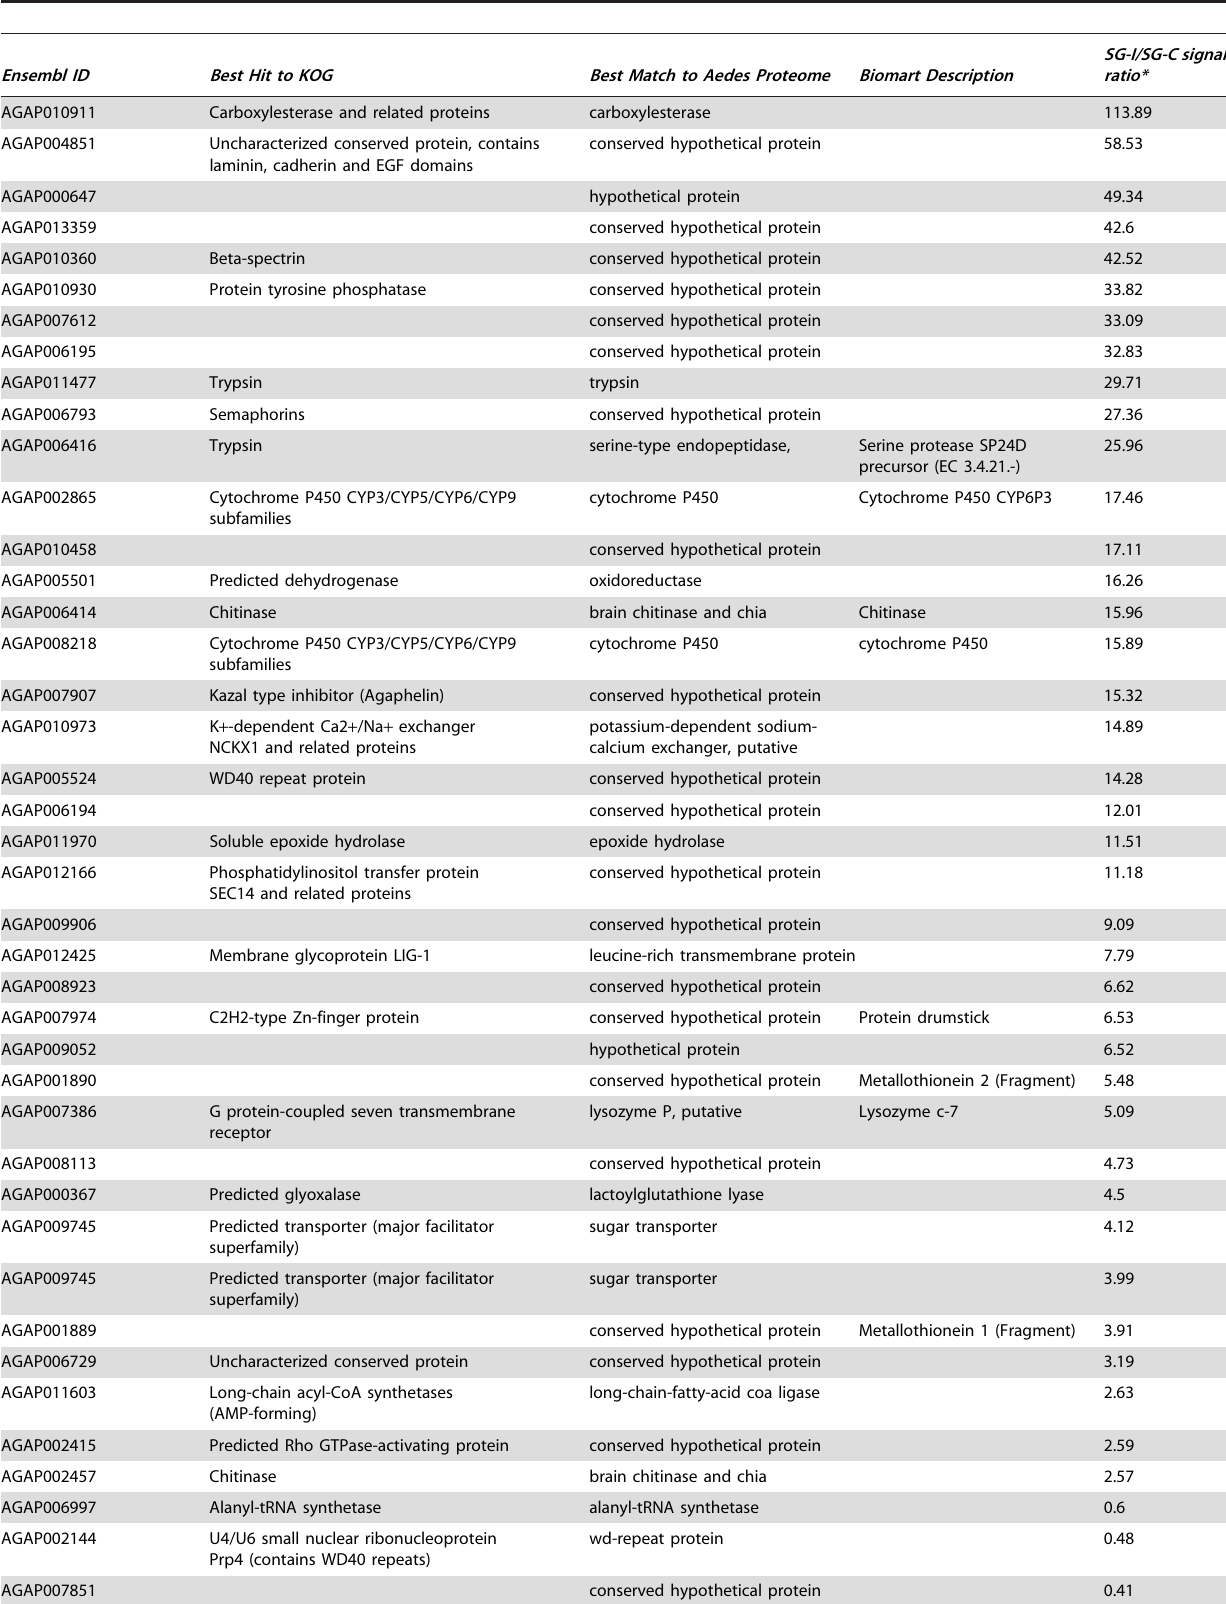
Table 1. List of genes considered to be differentially expressed in salivary glands of A. gambiae , upon infection with Plasmodium falciparum